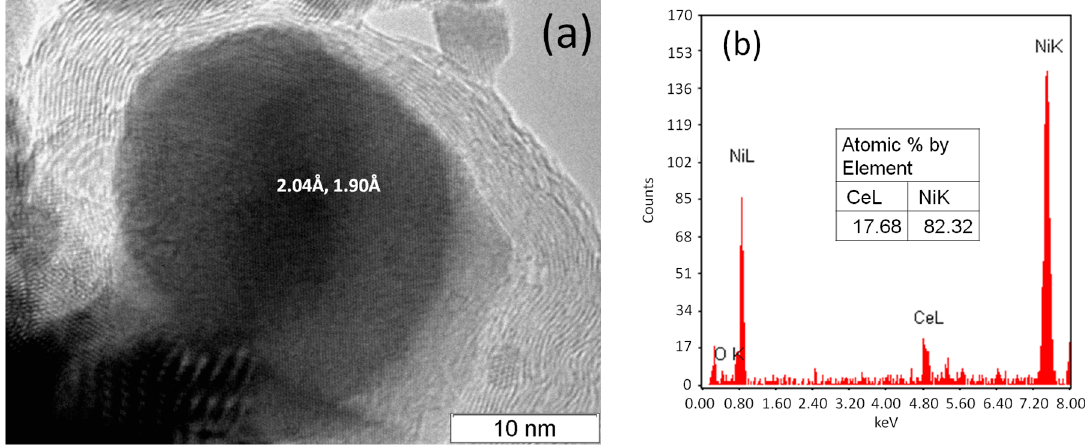
Figure 3. High resolution TEM image ( a ) and EDX spectrum ( b ) of 5% Ni/CeO 2 catalyst after reaction.